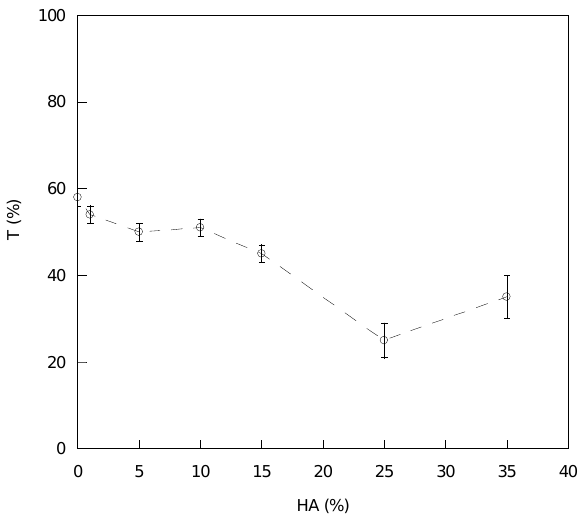
Figure 3. Optical transmittance (T%) of prepared films versus the HA amount.